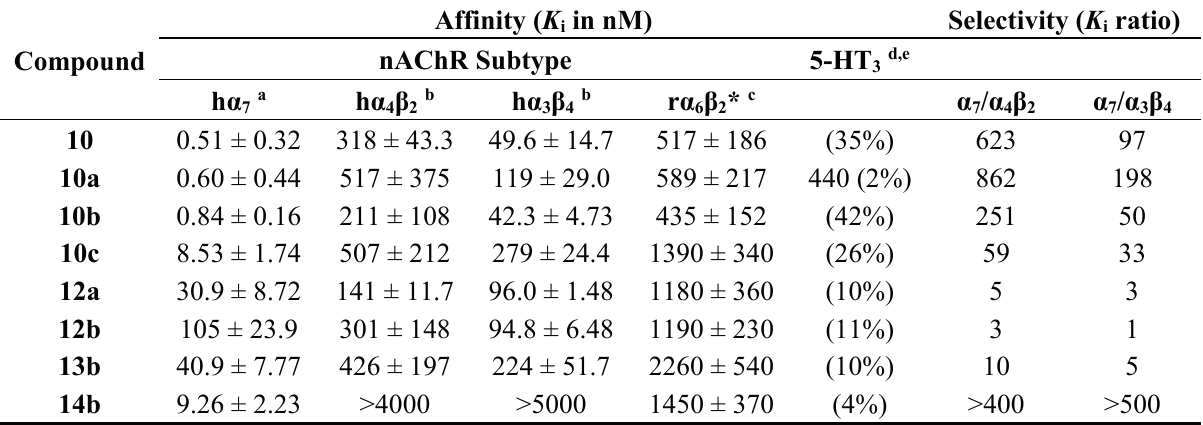
a Human α 7 nAChR in stably transfected SH-SY5Y cells, with radiotracer [ K D = 2.0 nM. b Human α 4 β 2 and α 3 β 4 nAChR in stably transfected HEK-293 cells, with